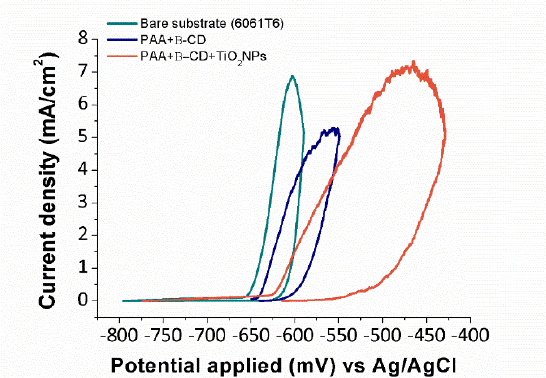
Figure 6. The cyclic polarization curves in 3.5% NaCl solution for aluminum bare substrate (black line), crosslinked PAA + β-CD electrospun fibers (blue line) and crosslinked electrospun fibers with metal oxide nanoparticles (PAA + β-CD + TiO 2 ∙NPs) (orange line), respectively.